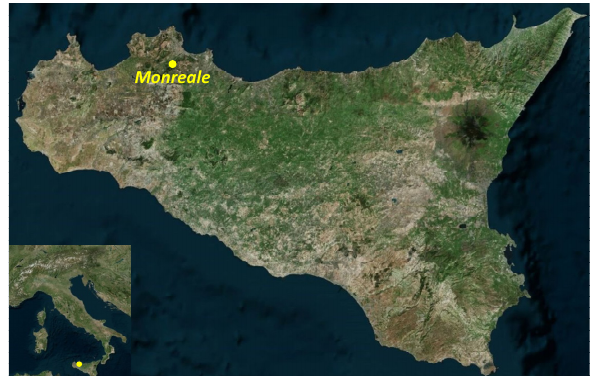
Figure 1. Location of the Cathedral of Monreale